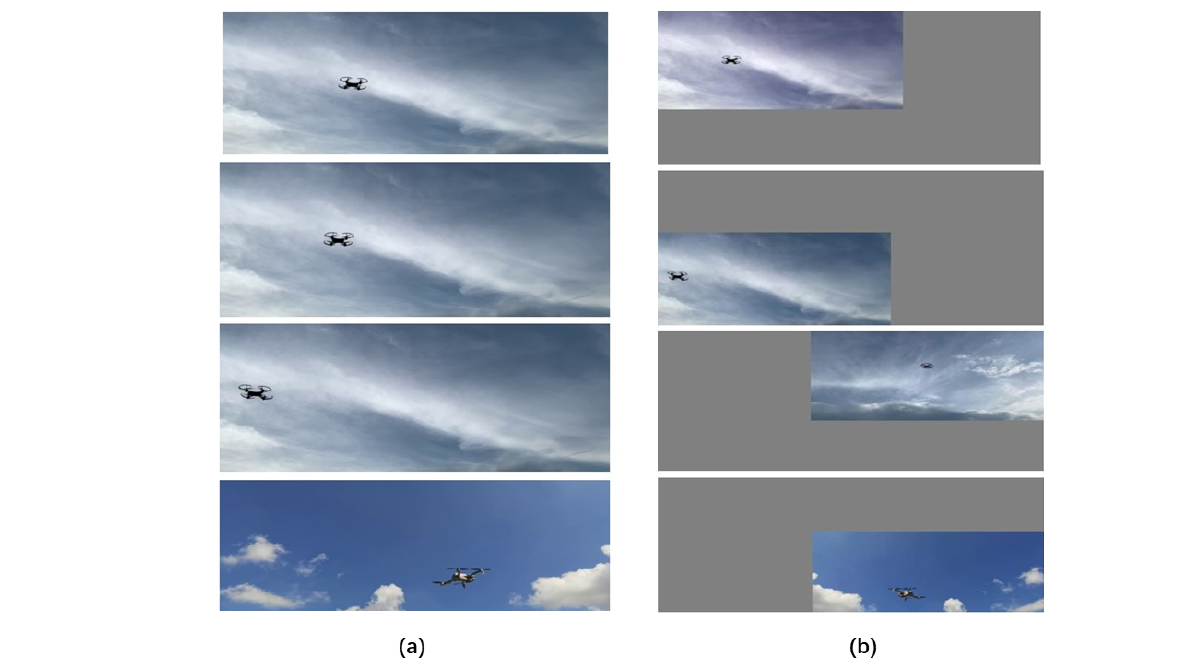
Figure 9. The process of mosiac data enhancement. ( a ) The four original images of the UAV dataset, ( b ) Images that have been flipped, scaled, colour gamut transformed, and placed in four orientations.